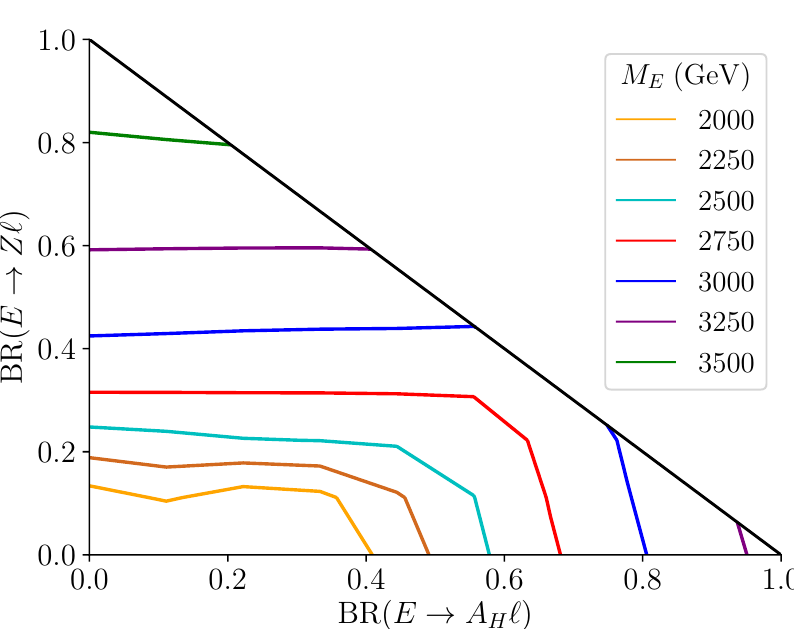
Figure 12 . Projected limits on the mass of the VLL, M E for arbitrary branching fractions for the 100 TeV hh-FCC. (See text and figure 9 for details.)